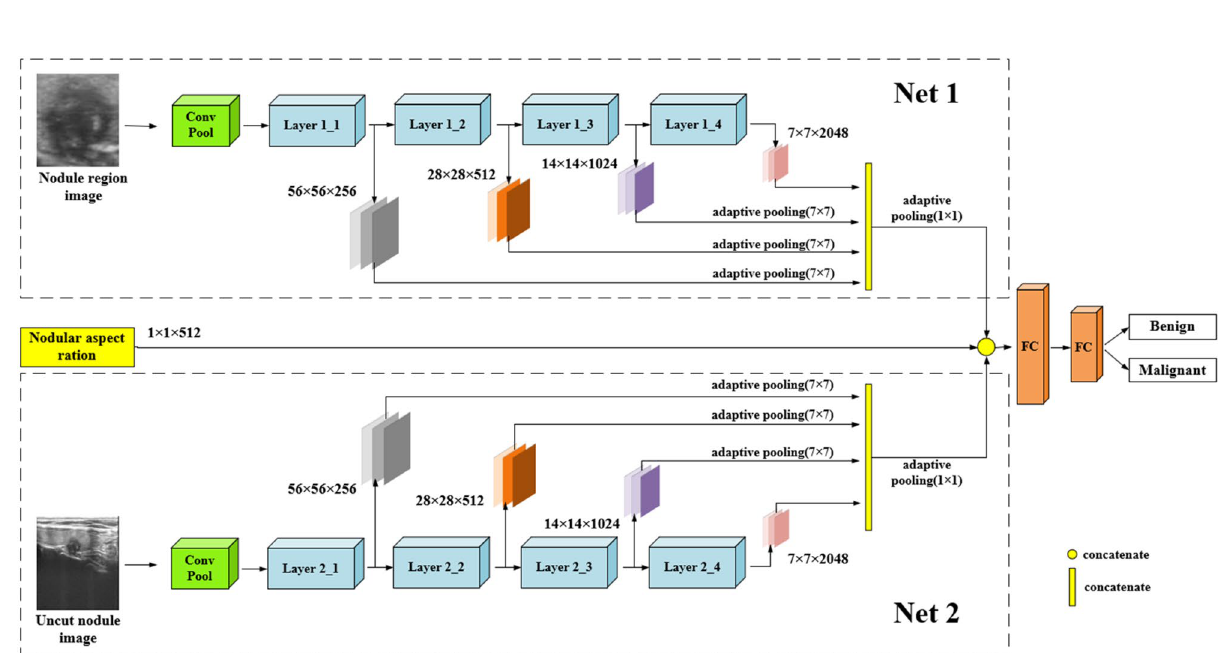
Figure 7. Classification network